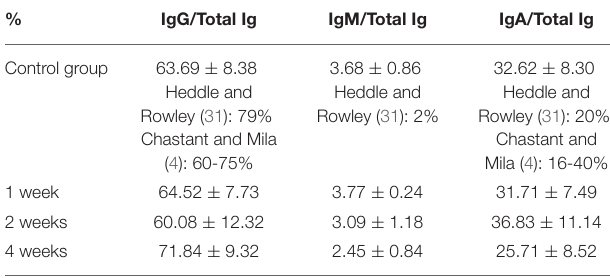
TABLE 4 | Percentage of each Ig category on total Ig in colostrum for every study group.